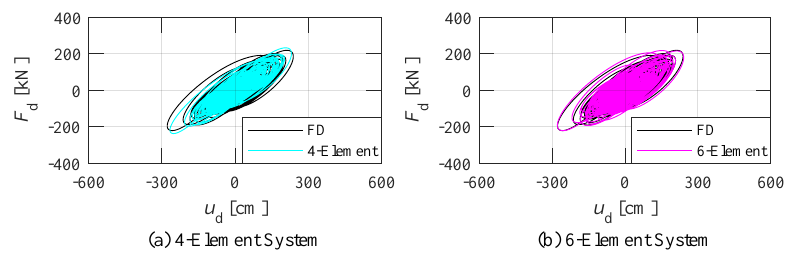
Figure 26. Comparison of hysteresis loop in the 2H-SS system (across-wind). Figure 27 illustrates the accumulated energy dissipation W d ( t ) of the VE dampers when subjected to across-wind. The accumulated energy dissipation of the 6-element system aligns with the FD system well. The accumulated energy dissipation of the 4- element is lower than the FD system with a significant difference. Compared with the along-wind, the across-wind energy dissipation has good agreement because the across- wind response is dominated by the resonance frequency and the narrow-band frequencies (see Figures 12 and 13). The frequency sensitivity of the 4-element, 6-element, and the FD systems at the resonance frequency has good agreements.